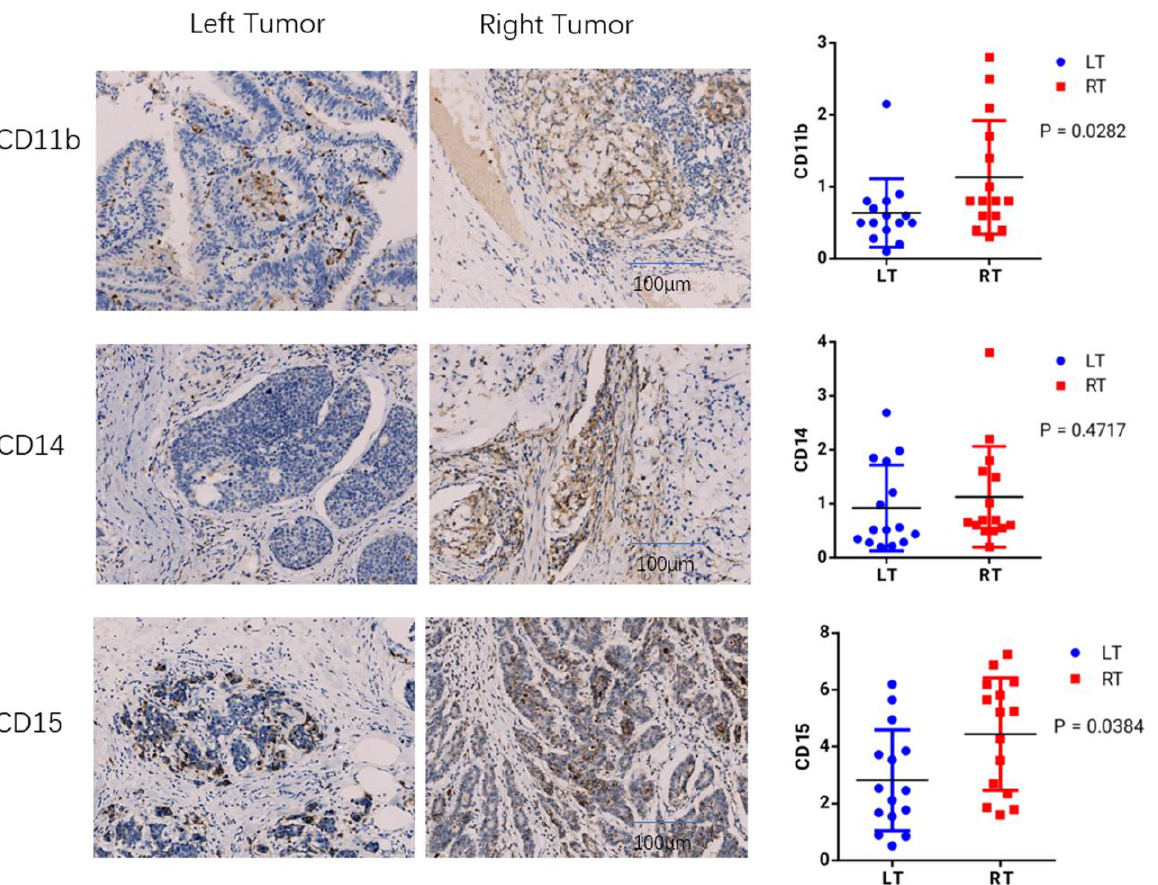
Figure 8. The immunohistochemical analysis. The expression of CD11b, CD14, and CD15 between left- and right-sided COAD were examined by immunohistochemical analysis. The relative expression levels of CD11b, CD14, and CD15 were also evaluated.